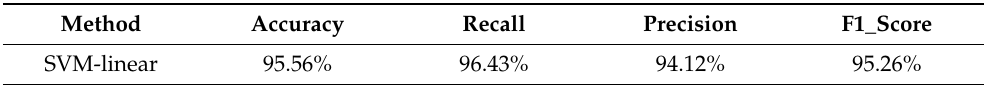
Table 8. Results using PSO-SVM Hyperparameter